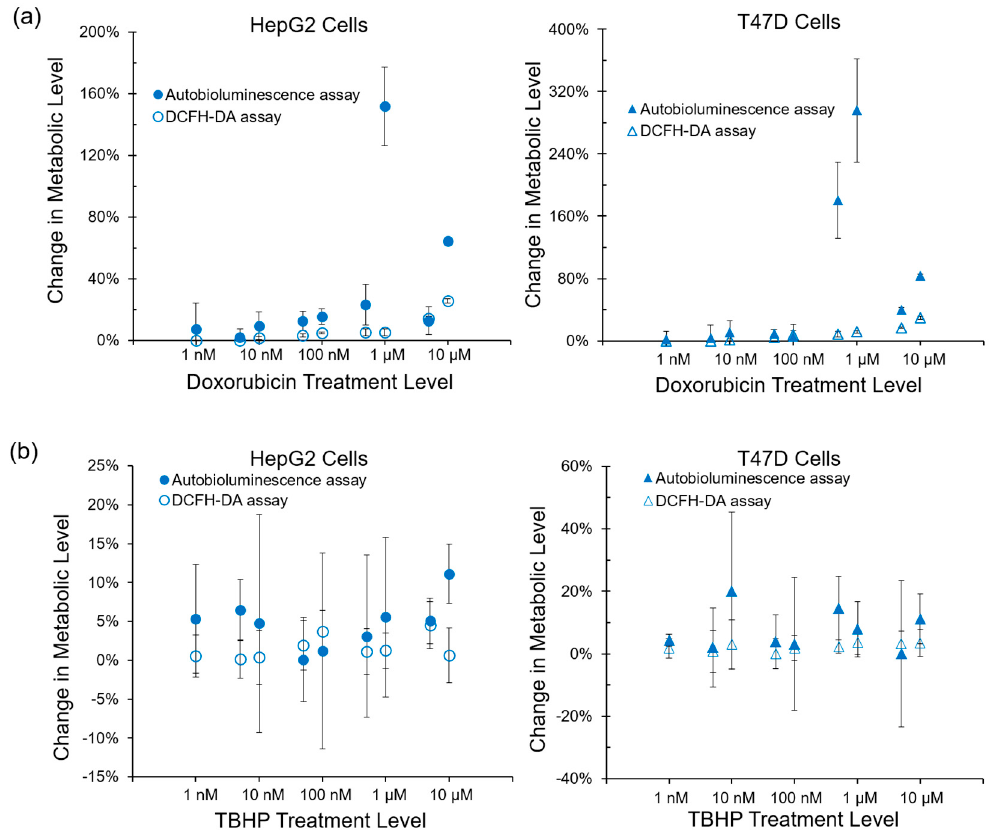
Figure 3. The autobioluminescence assay correlated with the fluorescent dichlorofluorescin diacetate (DCFH-DA) assay for the detection of reactive oxygen species as mediators of metabolic impact for both ( a ) Doxorubicin and ( b ) tert-butyl H 2 O 2 (TBHP). Values are the averages of triplicate tests, with error represented as SEM.